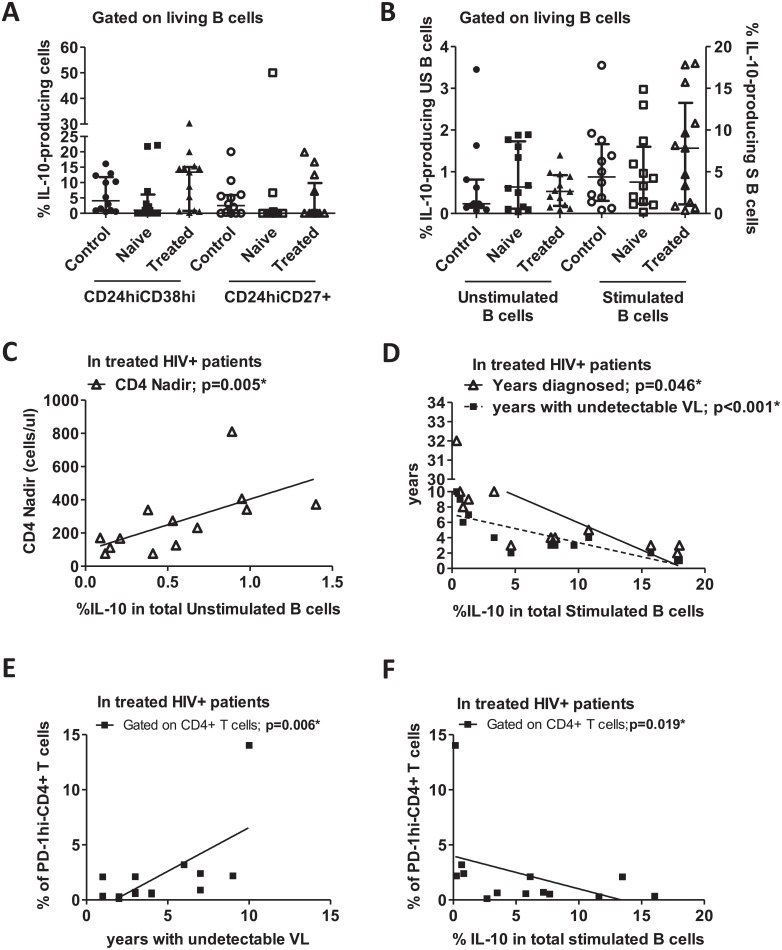
IL-10-producing Breg subsets in HIV+ patients and healthy individuals.PBMCs were isolated, and some cells were stimulated with CD40L/LPS/CpG. After 2 days, cells were labeled for surface markers and intracellular IL-10. (A) Frequencies of IL-10-producing-CD19+CD24hiCD38hi and CD19+CD24hiCD27+; (B) Frequencies of unstimulated (US) and stimulated (S) total IL-10-producing B cells. Frequencies were obtained with gating on CD19+ cells. (C) Correlation between basal expressions of IL-10 (frequency of IL-10-producing B cells without stimulation) and CD4 nadir count in treated-HIV+ individuals. (D) Correlation between frequencies of IL-10-producing B cells and years diagnosed or years with undetectable VL in treated-HIV+ individuals. (E) Correlation between frequencies of PD-1hi-CD4+ T cells and years with undetectable VL in treated-HIV+ individuals. (F) Correlation between frequencies of PD-1hi-CD4+ T cells and frequencies of IL-10-producing stimulated B cells in treated-HIV+ individuals. Medians ± IQRs are represented. Correlations were determined by Spearman’s rank correlation. Control: Healthy individuals. Naïve: HIV+ treatment-naïve individuals. Treated: Treated-HIV+ individuals. * = p<0.05. Each symbol corresponds to an individual.